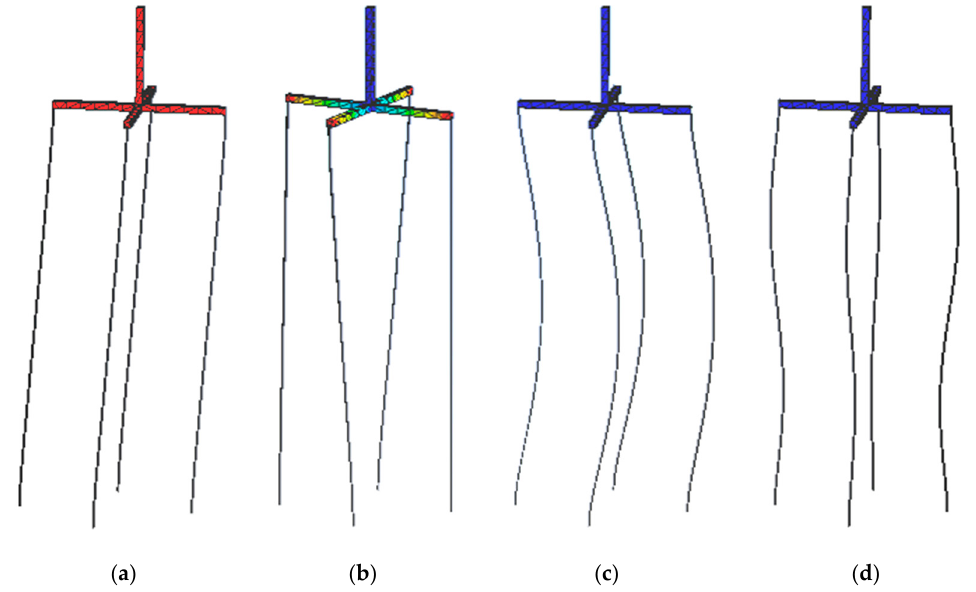
Figure 9. Mode shapes of TLP. ( a ) n = 1 (Surge); ( b ) n = 3 (Yaw); ( c ) n = 9 (Tether-1h); ( d ) n = 12 (Tether-2h).